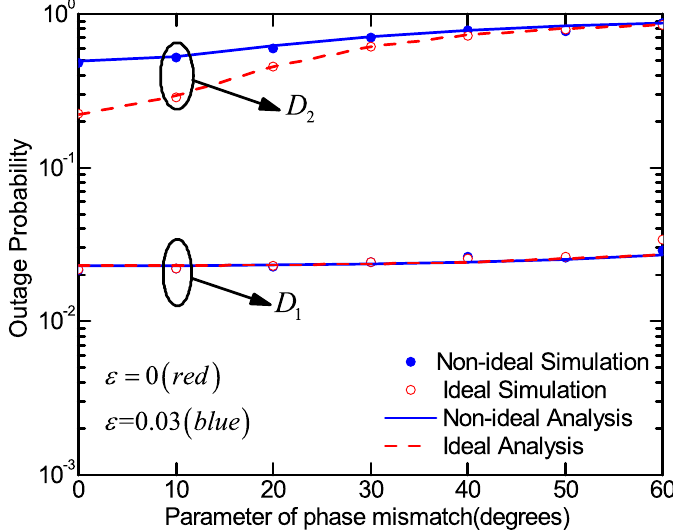
Figure 4. Outage probability versus the parameter of phase mismatch for the system with ipSIC and pSIC conditions.